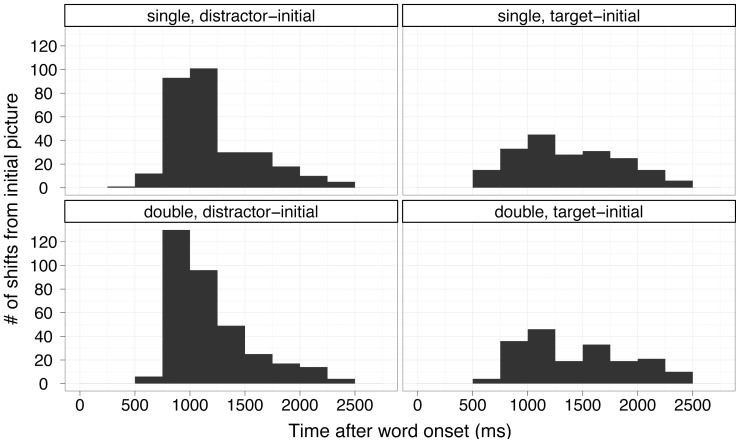
Histogram of refixations between, 367–1500 ms after target onset.Single and double refixations from target and distractor-initial trials, in 250 ms time-bins are shown. Analyses of distributions revealed no significant difference between singles and doubles (all p>.4, see text for details).